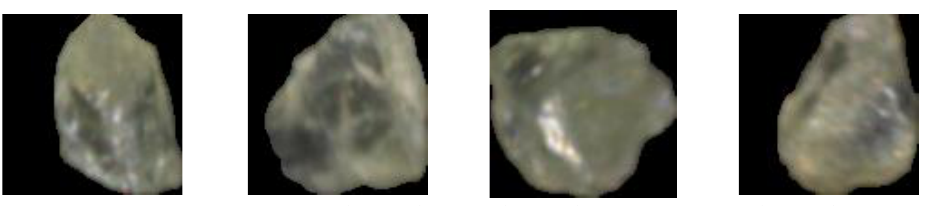
Figure 6. Sample images of the albite and quartz mineral grains.